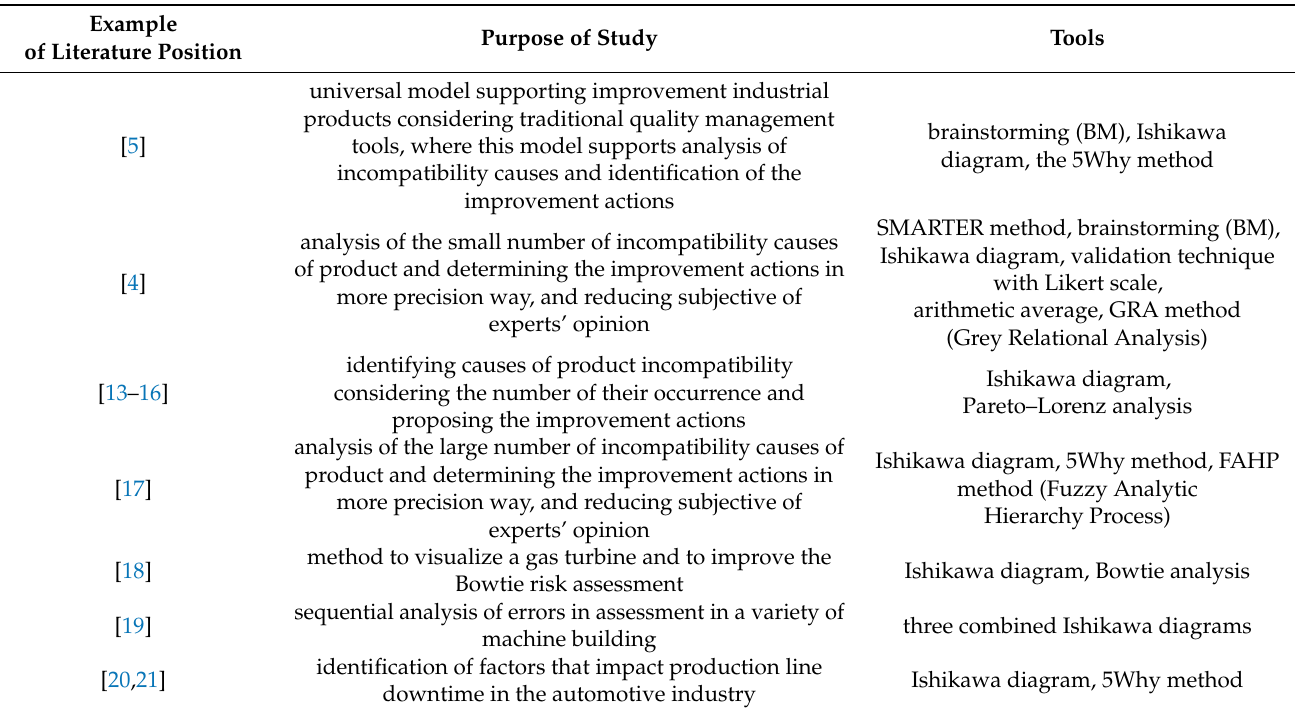
Table 1. Complex summary of literature